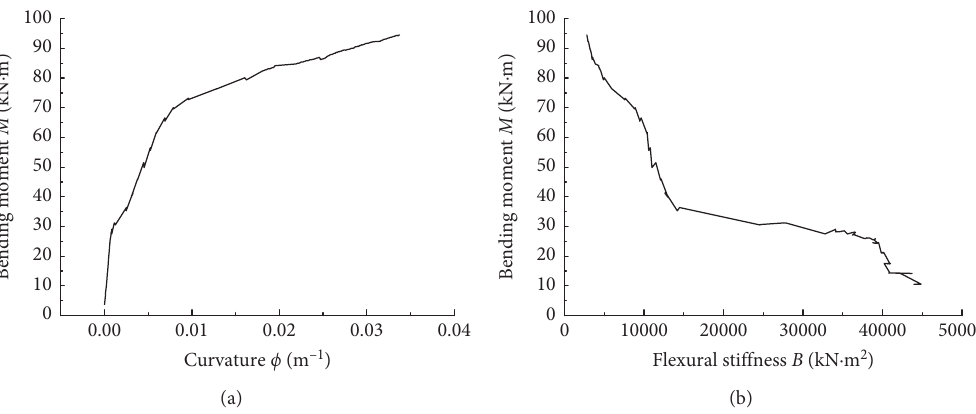
Figure 7: B-1-20-4. (a) Bending moment-curvature curve. (b) Bending moment-stiffness